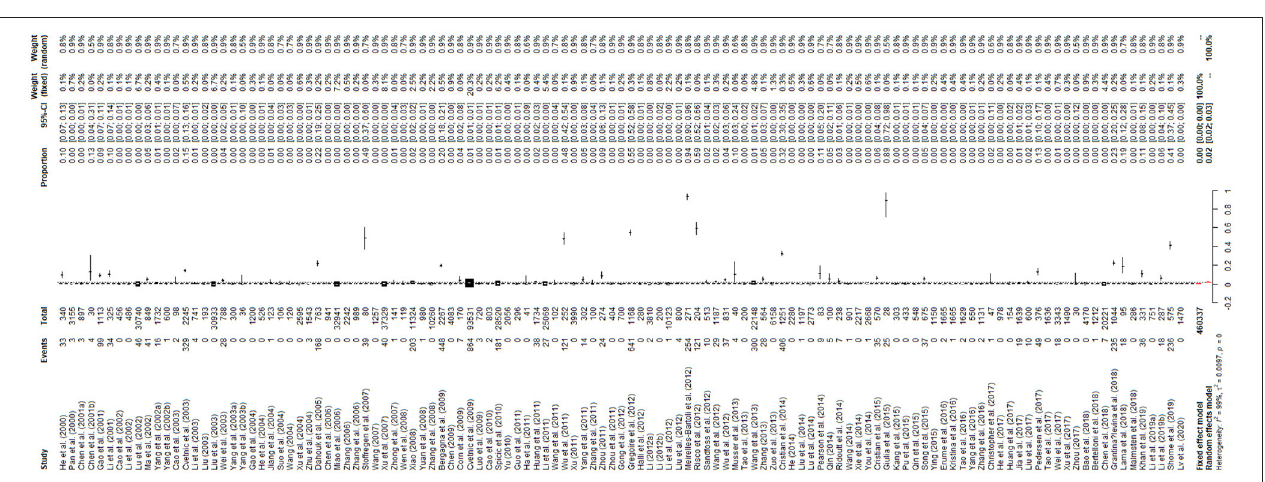
FIGURE 2 | Forest plot of the worldwide prevalence of Brucella spp. The length of the horizontal line represents the 95% confidence interval, and the diamonds represent the summarized